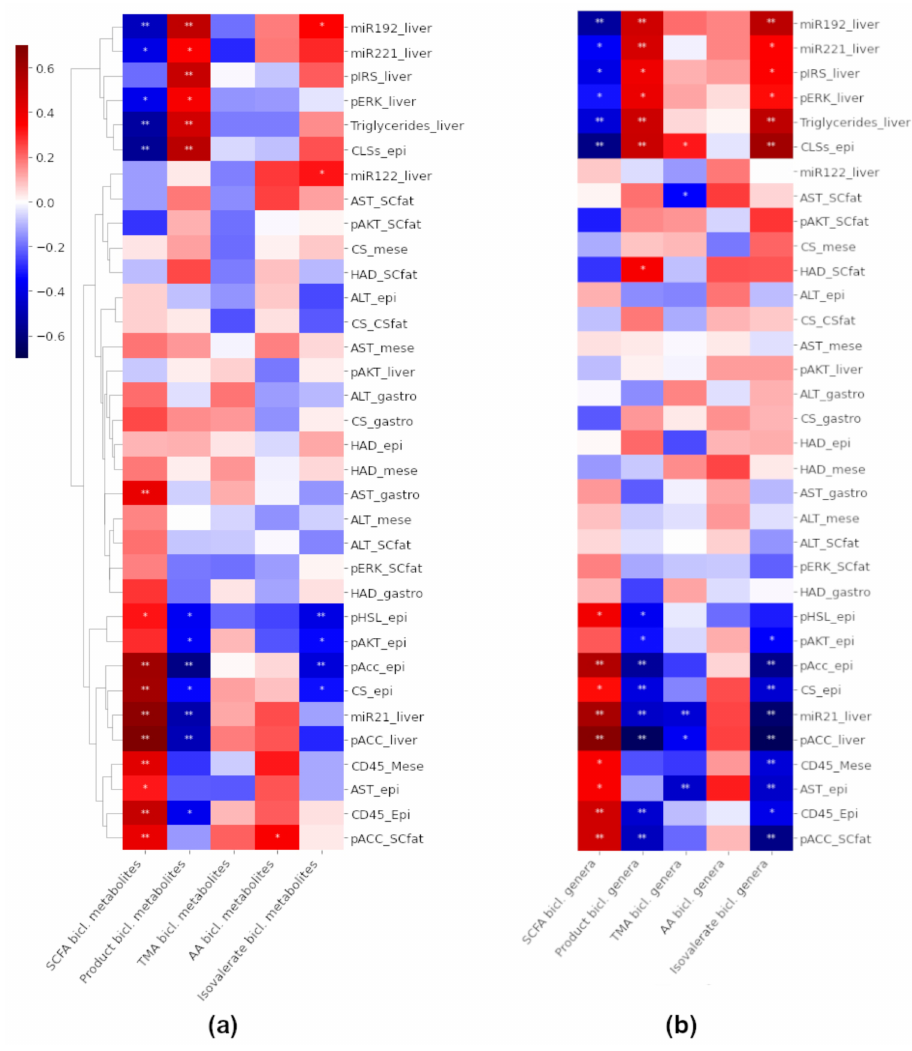
Figure 7. Heat maps of Spearman correlation coefficients between the total abundances of ( a ) The metabolites and ( b ) The genera in each bicluster and different biomarkers. The color of a node indicates the magnitude and the direction of correlation. Hierarchical clustering was applied to biomarkers. The raw metabolite abundances were summed, and the relative genus abundances were summed and then clr-transformed. epi = epididymal fat, mese = mesenteric fat, SCfat = subcutaneous fat, gastro = gastrocnemius muscle. * denotes p < 0.05 and ** p <